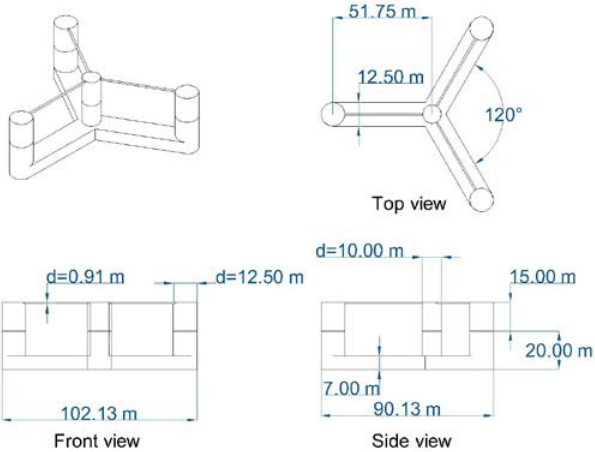
Figure 2. Detailed dimensions of the semi-submersible foundation. Table 2. Properties of the semi-submersible